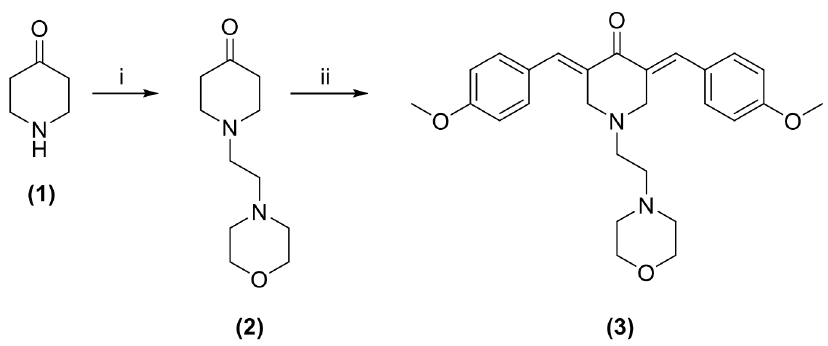
Figure 1. Synthesis pathway of compound 3 . (i) CH 3 CN, Cs 2 CO 3 , 4-(2-chloroehtyl)morpholine hydrochloride, reflux at 80 °C; (ii) C 2 H 5 OH, NaOH, 4-methoxybenzaldehyde, reflux at 80 °C.